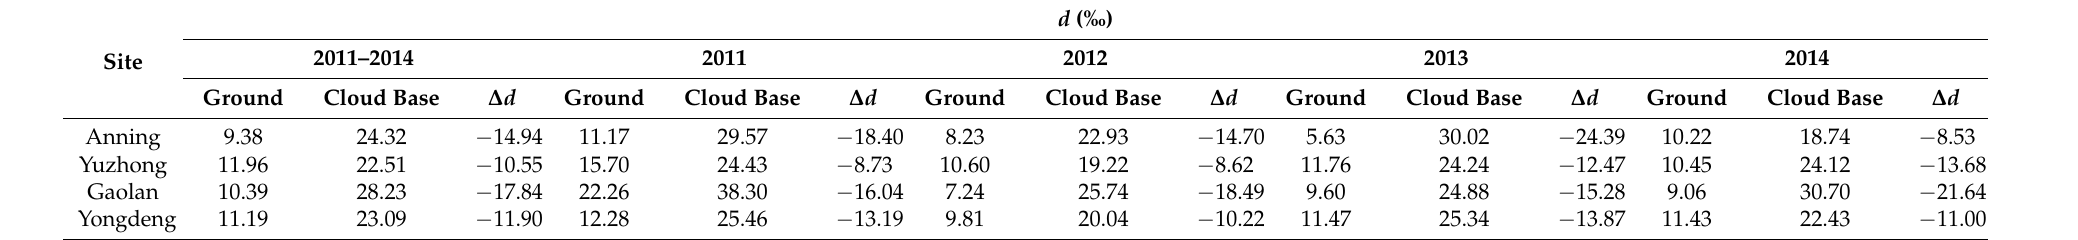
Table 1. Comparison of deuterium excess ( d ) in precipitation at land surface and cloud base for each year.